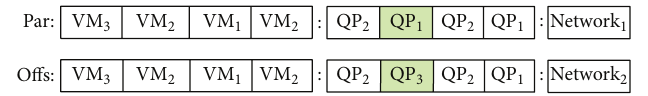
Figure 8: Mutation operator for the multiobjective optimization of query workloads.